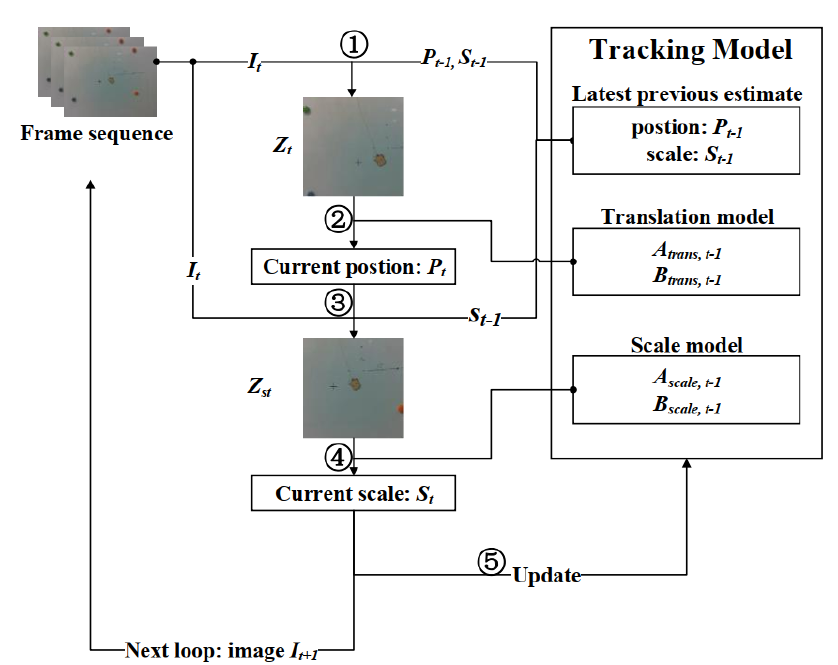
Figure 2. Illustration for the flow graph: 1 (cid:13) Extract sample Z t from I t at previous position P t − 1 and scale S t − 1 with multi-channel features; 2 (cid:13) Compute translation correlation scores y trans , t according to Equation (5) and find the current estimated target position P t where the maximum located in y trans , t ; 3 (cid:13) Extract sample Z st from I t at current position p t and scale S t − 1 ; 4 (cid:13) Compute scale correlation scores y scale , t according to Equation (6) and find the current estimated target scale S t where the maximum located in y scale , t ; 5 (cid:13) Update translation model and scale model according to Equations (7)–(9), then save the current position and scale as the latest previous